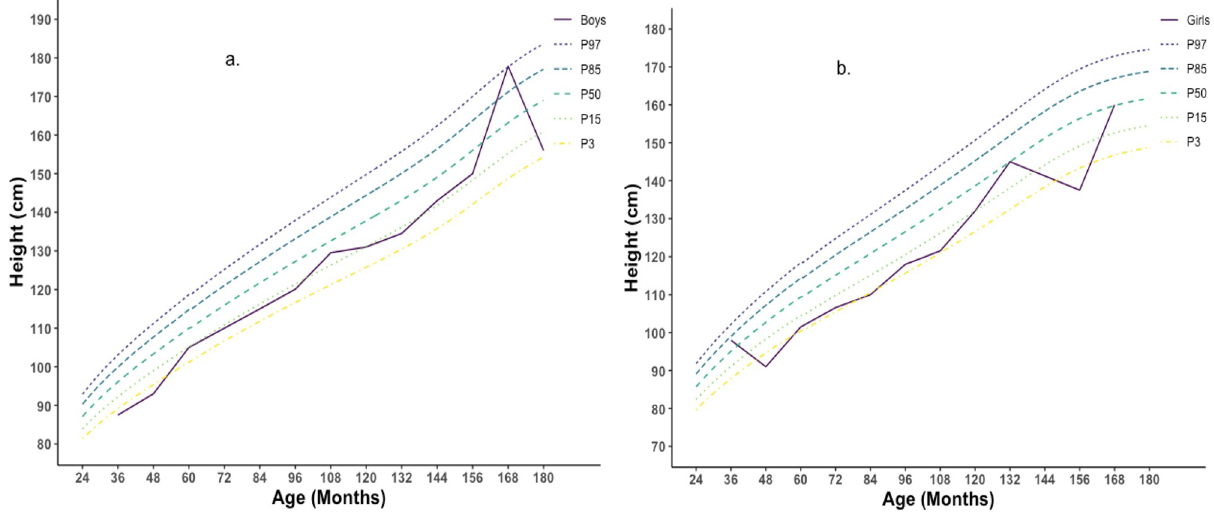
Fig 7. Height for age percentile for Boys (a.) and Girls (b.) (n = 330) [Graphs was generated using